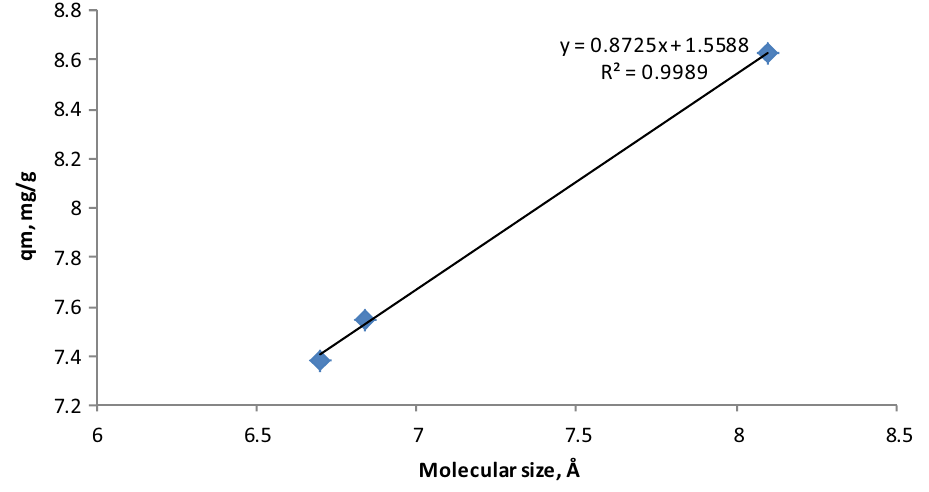
Fig. 7 Relation between